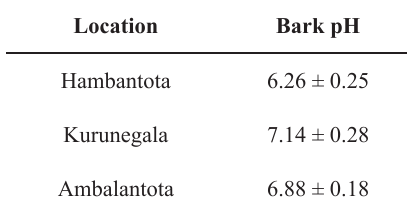
Table 2: Bark pH values of L. acidissima